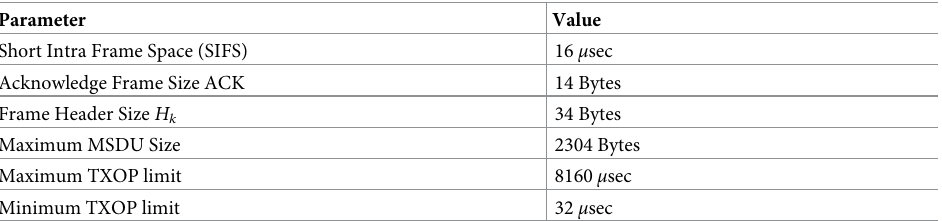
Table 2. System parameters [11].